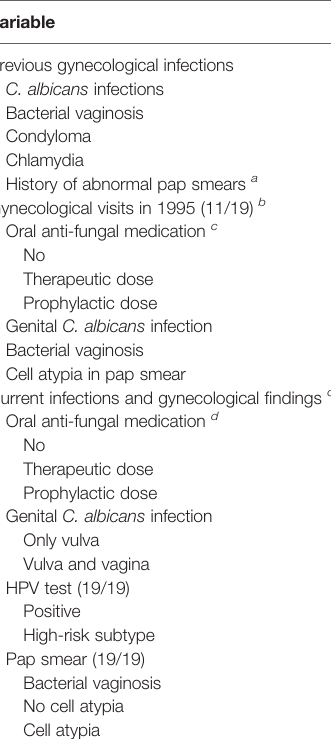
TABLE 3 | Previous and current gynecological infections and pap smear fi ndings in 19 patients with